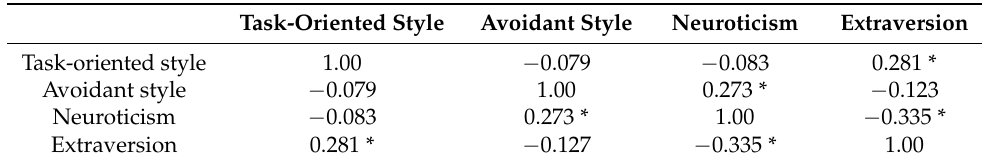
Table 1. The relationship between the intensity of selected personality dimensions and styles of coping with stress among healthy people and people diagnosed with schizophrenia (Spearman R-coefficient) (n = 60). Task-Oriented Style Avoidant Style Neuroticism Extraversion Task-oriented style